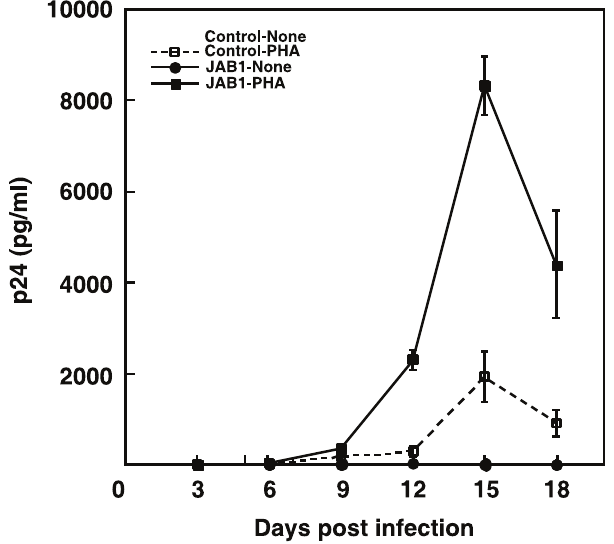
Figure 6. JAB1 promotes HIV-1 replication in activated primary CD4 + T cells. pBMN-control-IRES-Lyt2 a ’ and pBMN-JAB1-IRES-Lyt2 a ’ retrovirus vectors were transduced into human primary CD4 + T cells. CD4 + T cells were challenged with HIV-1 (NL4-3) at doses of 400 TCID 50 per 1 6 10 5 cells with or without PHA stimulation. p24 gag levels in culture supernatants were assayed from four wells on the indicated days after infection. p24 gag levels were normalized for cell number determined using an XTT assay. Data are presented as the average 6 SE per 10 6 cells. Similar results were observed in three independent experiments.